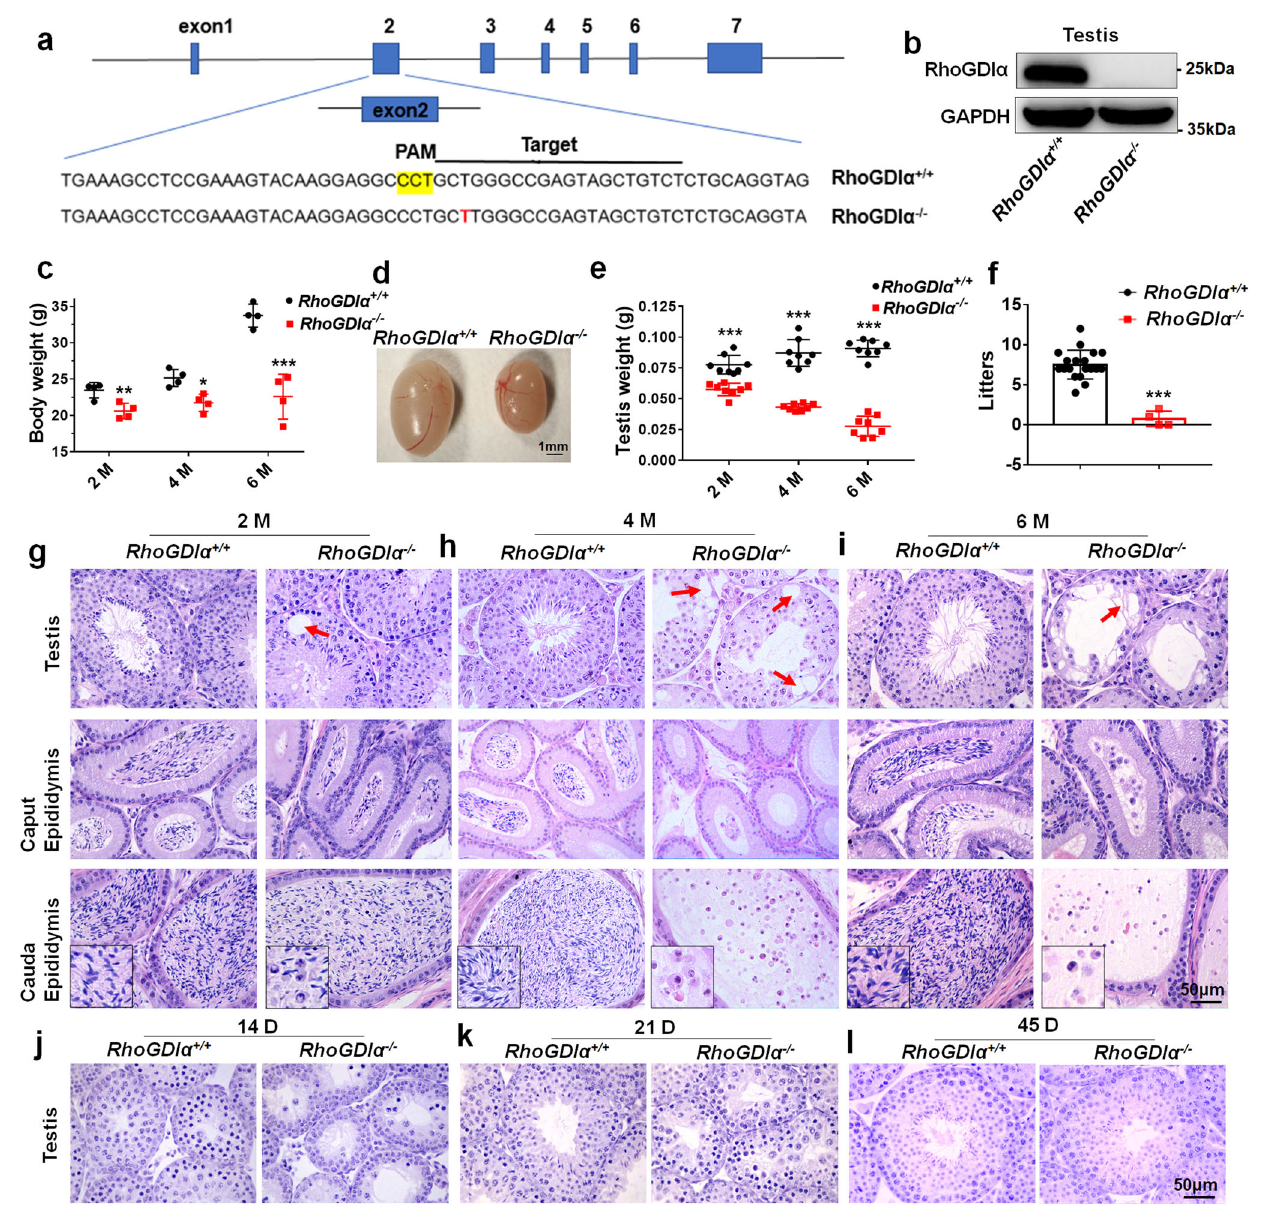
Fig. 1 Testis showed progressive damage in RhoGDI α − / − mice. a Schematic diagram of sgRNA targets for the RhoGDI α genome, and sgRNA target sites located in exon 2. b Western blot analysis was used to test the RhoGDI α protein, which was not expressed in RhoGDI α − / − mice. c Body weight was checked in RhoGDI α + / + and RhoGDI α − / − male mice at 2 months (2 M), 4 months (4 M), and 6 months (6 M) of age. n = 4 biologically independent animals. d Photograph of RhoGDI α + / + and RhoGDI α − / − mouse testes. Scale bar = 1 mm. e Weight of mouse testes at 2 months, 4 months, and 6 months of age. n = 8 biologically independent animals. f Litters of mating WT female mice with RhoGDI α + / + and RhoGDI α − / − male mice for 3 months. n = 3 biologically independent male mice. g – i Histology of testis, caput, and cauda epididymis examined using H&E staining of mice at 2 months, 4 months, and 6 months of age. Red arrows indicate vacuolated seminiferous epithelium, while black boxed areas are higher-magni fi cation images of cauda epididymis. j – l H&E staining result of RhoGDI α + / + and RhoGDI α − / − mouse testes at 14 days, 21 days, and 45 days of age, respectively. Scale bar = 50 μ m. * P < 0.05, ** P < 0.01, *** P < 0.001 vs RhoGDI α + / + . Data are presented as the mean ± standard